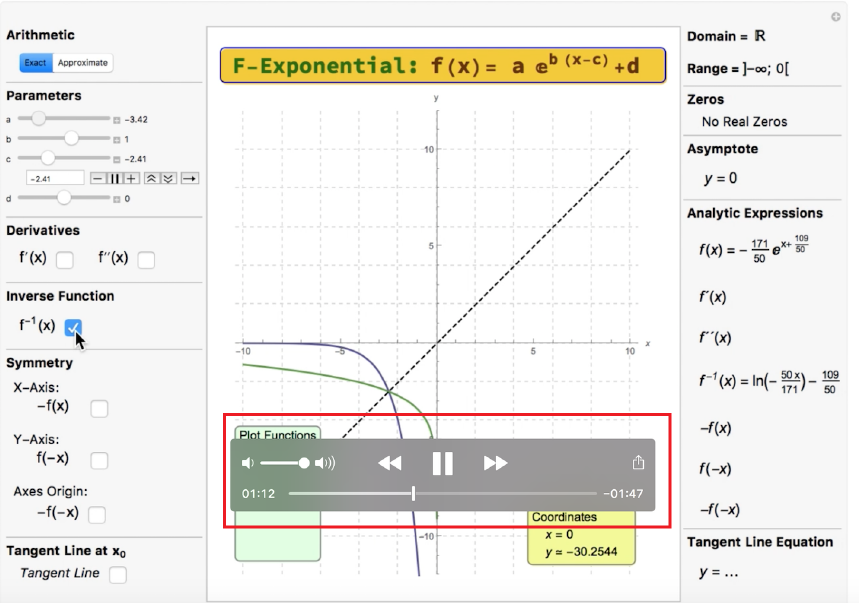
Figure 13. Video on the invertibility concept produced by the author (using the F-Exponential tool [26]) and available in the learning management system moodle of the